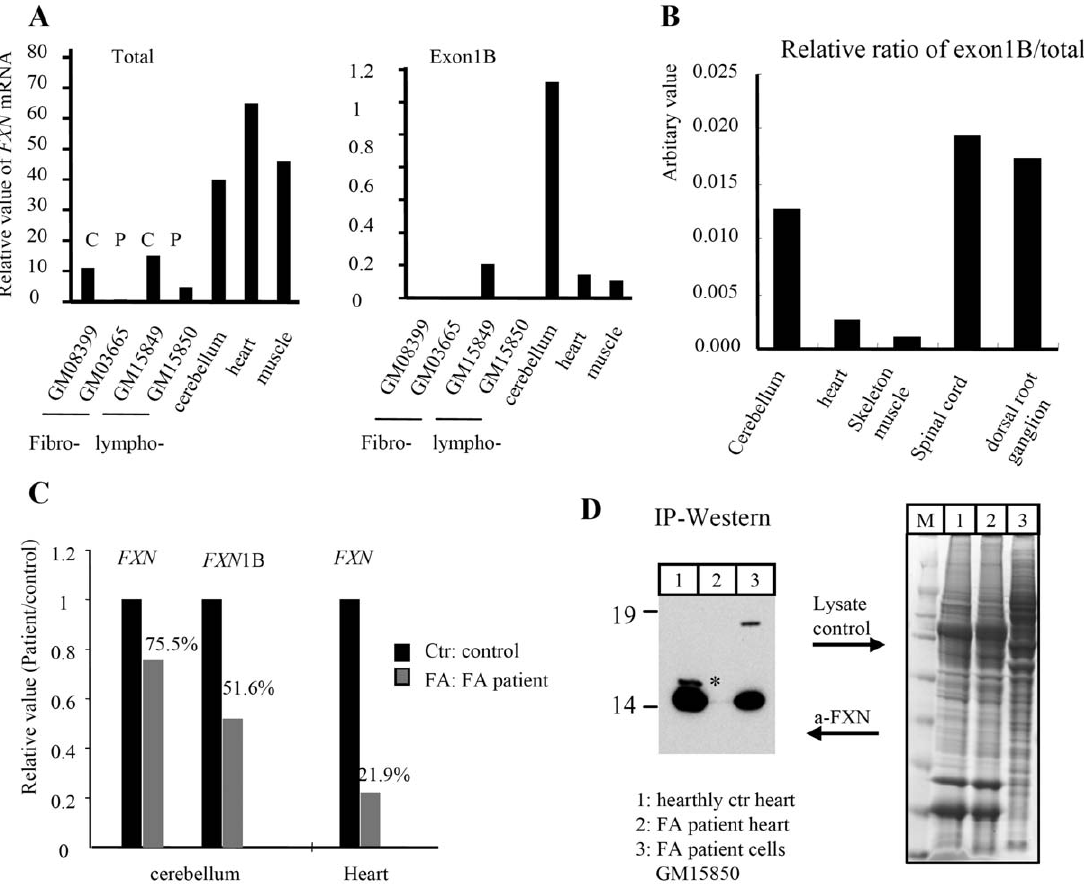
Figure 3. Novel transcripts and/or isoforms of human FXN showed the tissue-specific expression pattern. ( A ) Quantification of frataxin transcripts by qRT-PCR. Total: total mRNA of FXN , exon1B: exon1B-containing transcript of FXN . Human tissues including cerebellum, heart, and skeletal muscle and cells including fibroblasts (fibro-) and lymphoblasts (lympho-) derived from healthy controls (C) and FRDA patients (P) were analyzed. ( B ) Ratio of transcripts containing exon1B to total FXN in human tissues. ( C ) Quantification of FXN transcripts in FRDA patient heart and cerebellum, compared to healthy controls. No standard deviation due to 2–3 samples of each tissue from controls or patients is provided. Values are the relative means. ( D ) Immunoprecipitation (IP) of human FXN in a healthy and FA patient heart and patient lymphoblast cells. Lysate before IP was loaded to run a SDS-PAGE gel and then to be stained with Coomassie as a sample control for comparison. Left panel: IP-Western, anti-FXN; right panel: Coomassie-stain sample control. *: a novel heart-bearing FXN band.